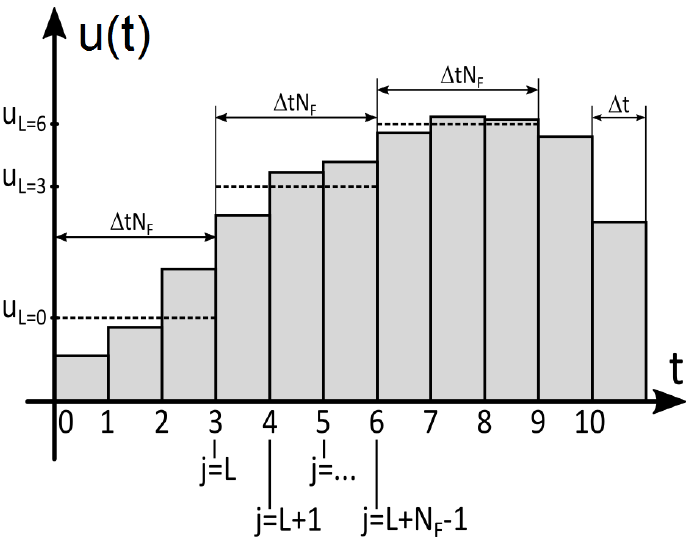
Figure 3. Diagram illustrating the calculation of u L using future time steps. The least squares method is applied to estimate parameters u L . The sum of squares